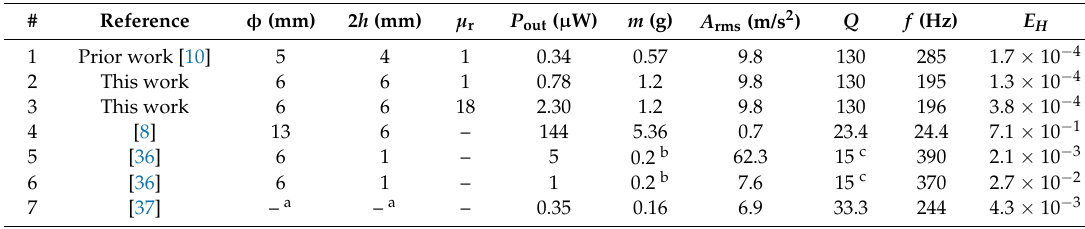
Table 4. Harvester effectiveness